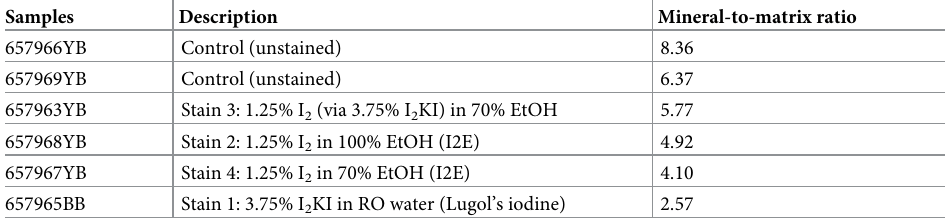
Table is ordered by decreasing Mineral-to-matrix